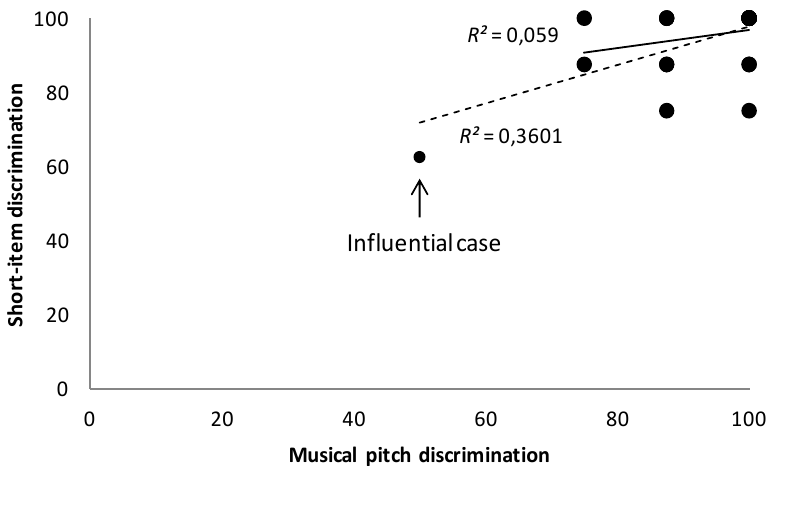
Figure 2. Relationships between musical pitch discrimination and performance on the short-item discrimination task in the TD group before and after removing an influential case. The dashed line represents the regression function before the removal of the influential case. The solid line shows the regression function after the removal of this